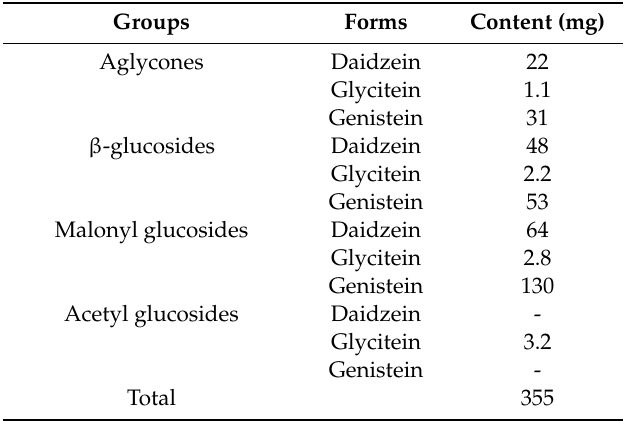
Table 5. Contents of the twelve isoflavones in okara (mg per g dry